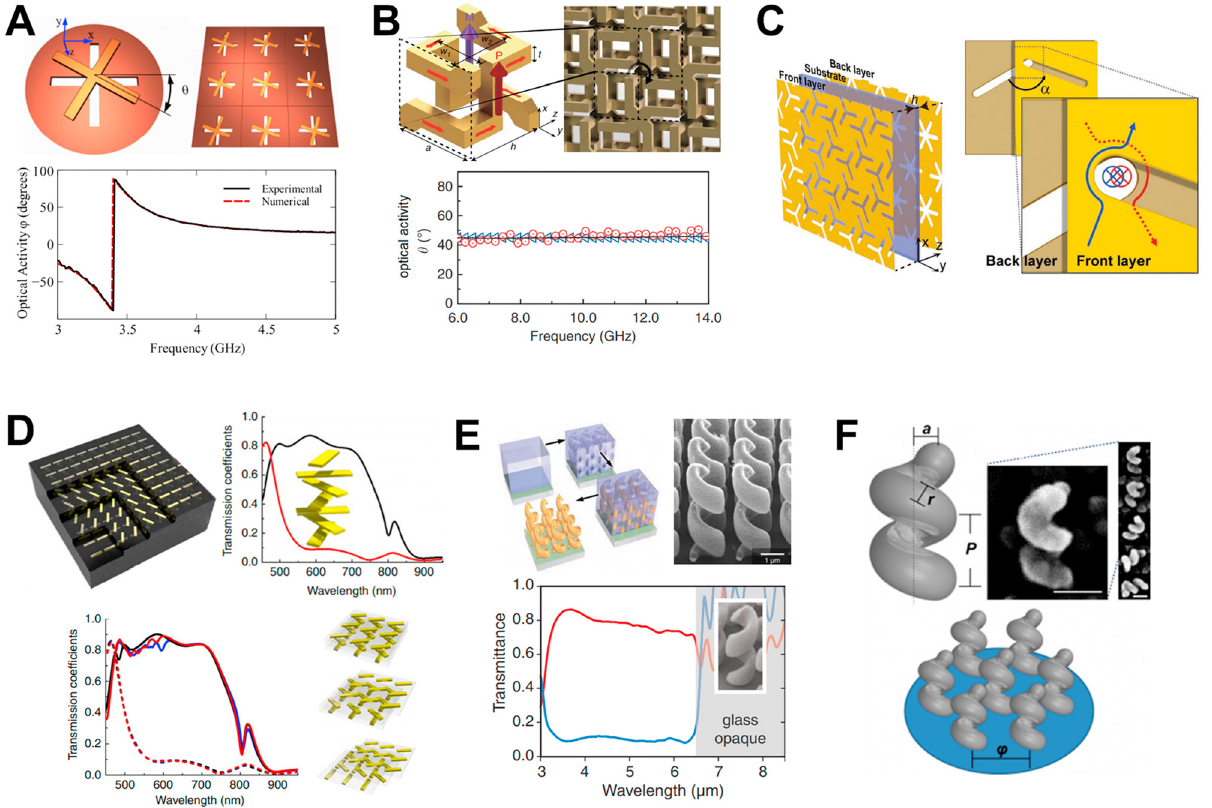
Figure 5: Metamaterials with broadband optical activity or broadband circular dichroism. (A) An array of rotated complementary crosses. Transmission resonance occurs around 4.5 GHz (not shown). Adapted with permission from Ref. [66]. Copyright 2014, American Physical Society. (B) Three-dimensional metallic interconnection with Drude-like response. Adapted with permission from Ref. [67]. Copyright 2014, Springer Nature. (C) Two metallic layers with aligned slit tips are strongly magnetically coupled while the electric coupling is minimized. Adapted with permission from Ref. [69]. Copyright 2019, WILEY ‐ VCH. (D) A helical stack of highly anisotropic effective layers. Adapted with permission from Ref. [70]. Copyright 2012, Springer Nature. (E) Metallic helix array realized with direct laser writing. Adapted with permission from Ref. [71]. Copyright 2009, American Association for the Advancement of Science. (F) Similar structure realized by glancing angle deposition where their feature size is tens of nanometer scale. Adapted with permission from Ref. [73]. Copyright 2013, AIP